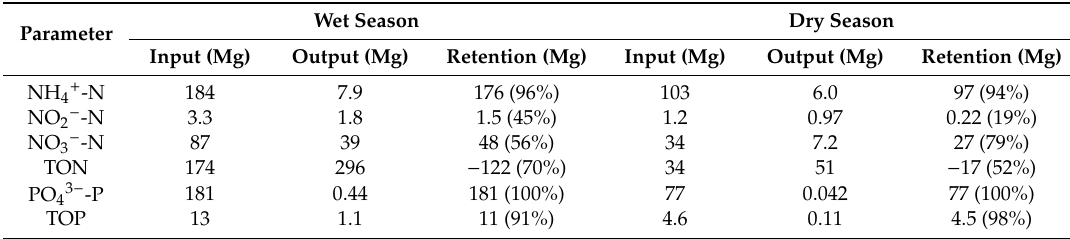
Table 3. Annual nitrogen and phosphorus budget for Lake Parano á during the wet and dry seasons.